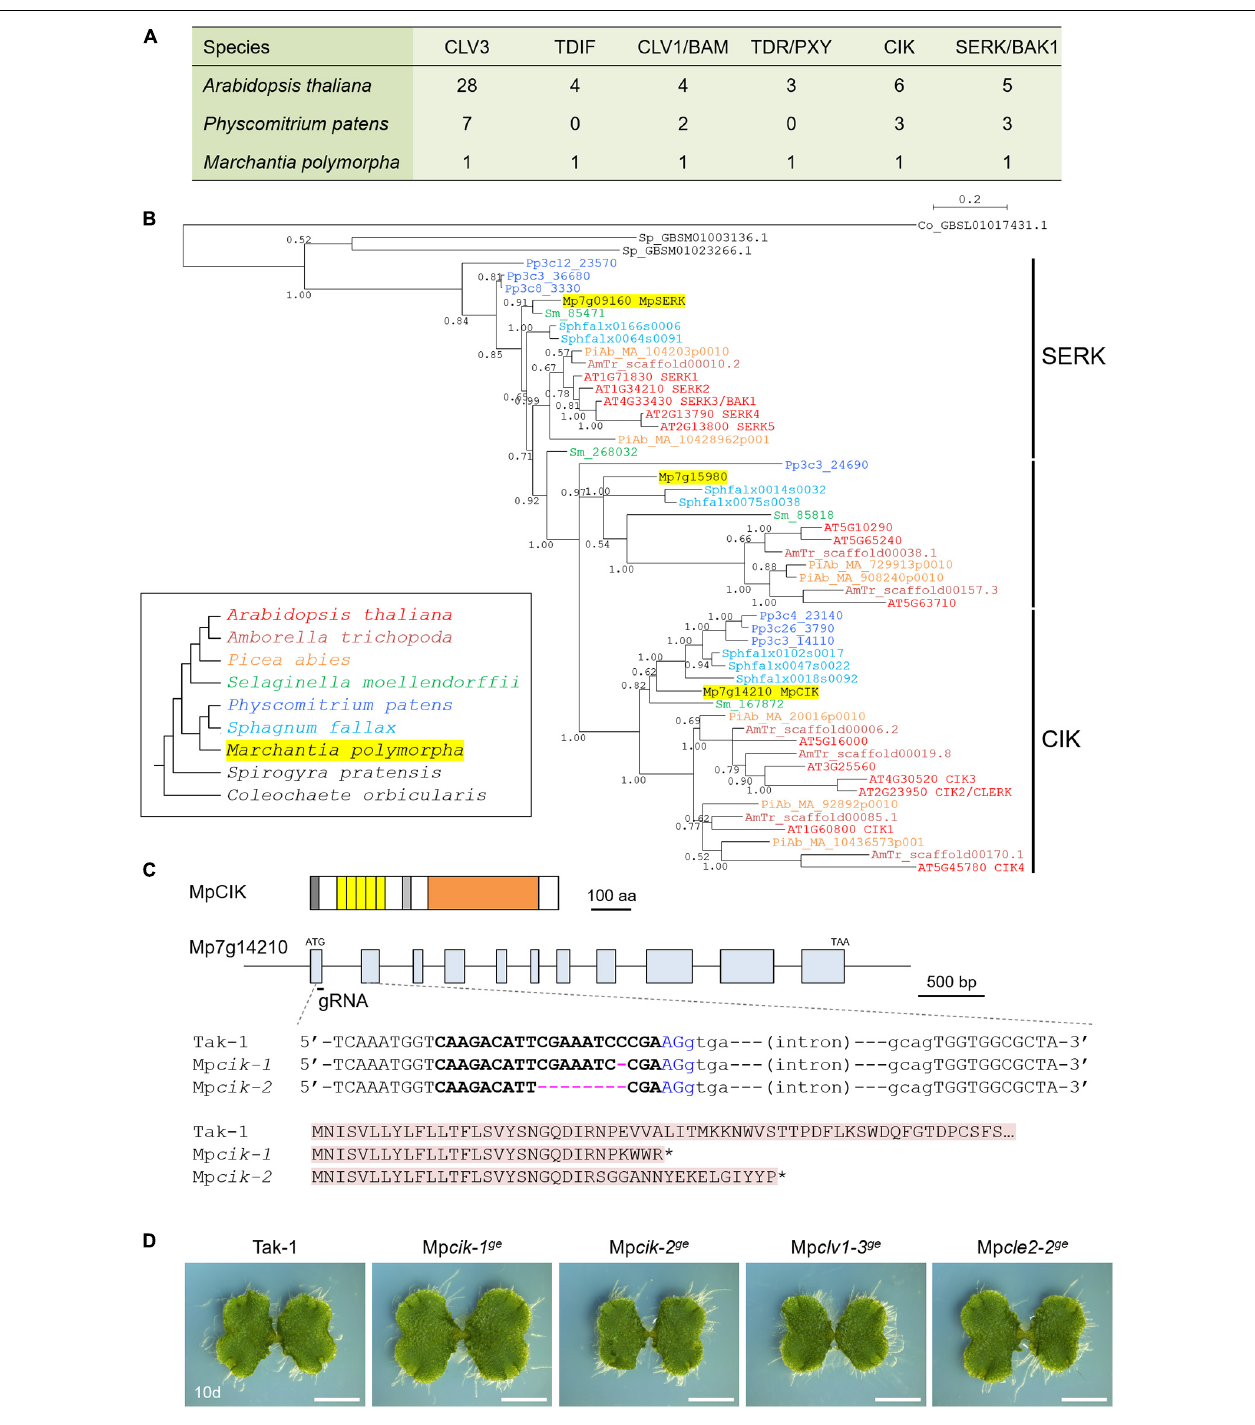
FIGURE 1 | Analysis of LRR-RLK subclass II in Marchantia polymorpha . (A) The number of CLE-receptor homologs. (B) A phylogenetic tree of subclass-II LRR-RLKs, generated with a Bayesian method based on the conserved kinase domain. The posterior probabilities of trees are shown at the nodes. Coleochaete sequence was used as an outgroup. Land plant sequences form a monophyletic clade, which can be divided into three subgroups as indicated on the right. Inset shows the list of species with their phylogenetic relationships. (C) Gene/protein structures and genome editing alleles of MpCIK. (top) Protein structure of MpCIK. (middle) Structure of MpCIK/Mp7g14210 locus with the position of a designed guide RNA (gRNA). (bottom) Genotyping of genome editing alleles. Target guide sequence is in bold and PAM sequence is in blue. Deleted bases are indicated with hyphens in magenta. Exon and intron are indicated in capital and small letters, respectively. N-terminal region of WT and mutant proteins deduced from the genomic DNA sequences are indicated below. Asterisks indicate translational termination. (D) Overall morphology of 10-day-old plants grown from gemmae. Scale bars represent 0.5 mm.